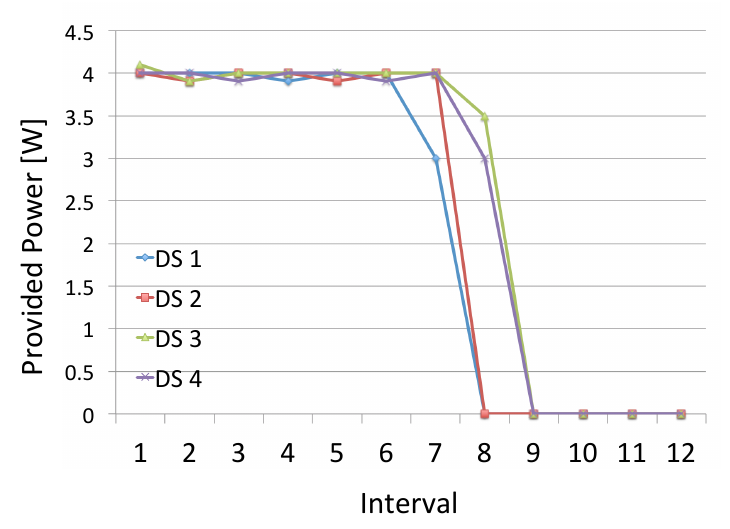
Figure 21. The transition of the power supply from distributed storage.